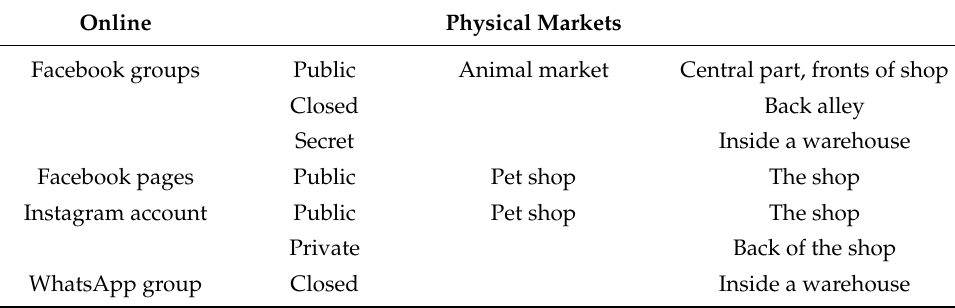
Table 1. Comparison of the different mechanisms by which animals can be sold on social media, with the mechanisms used to sell them in physical